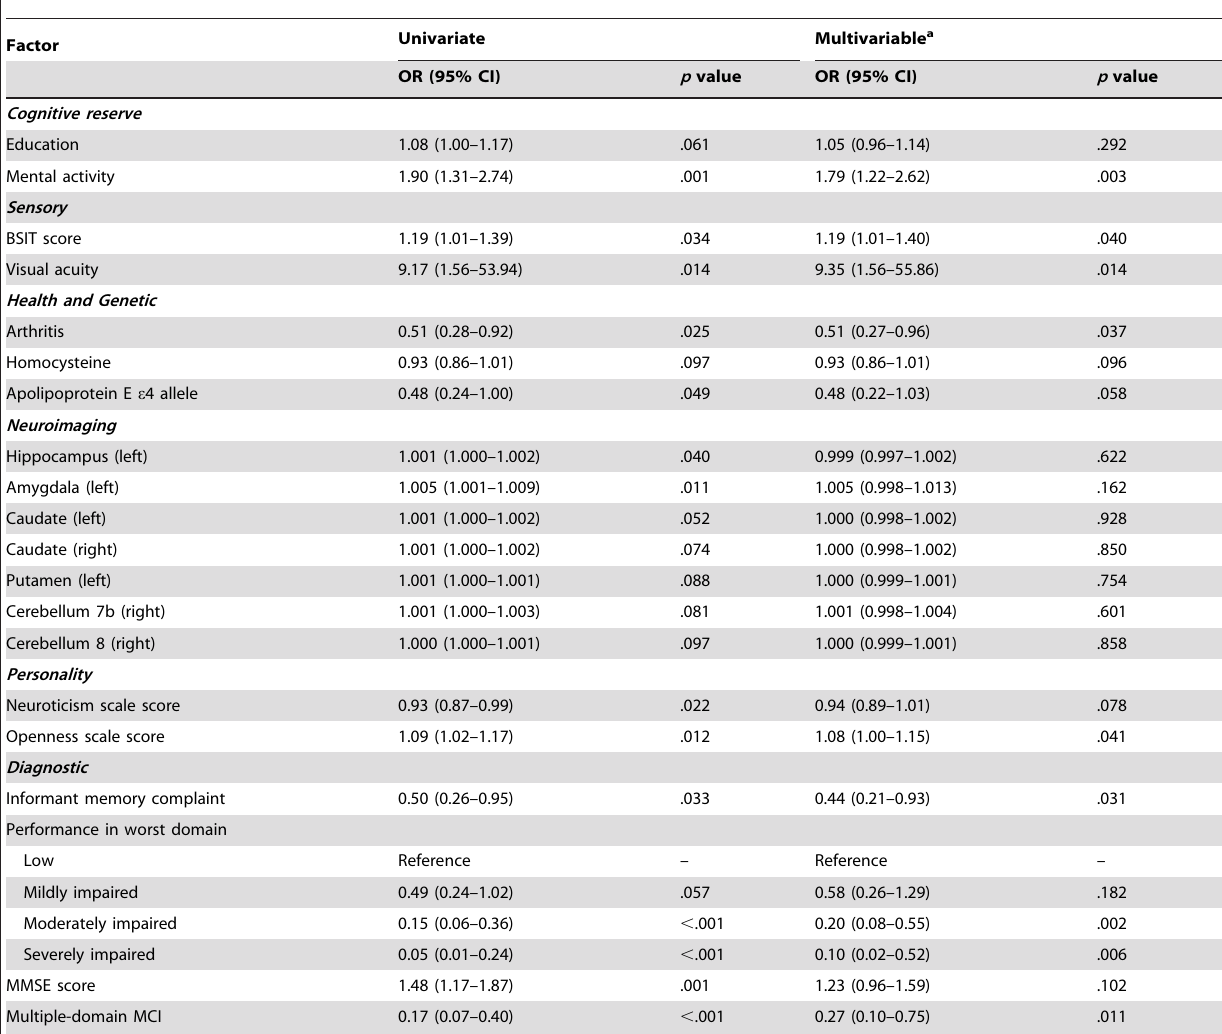
Table 3. Baseline factors associated with reversion from MCI to normal